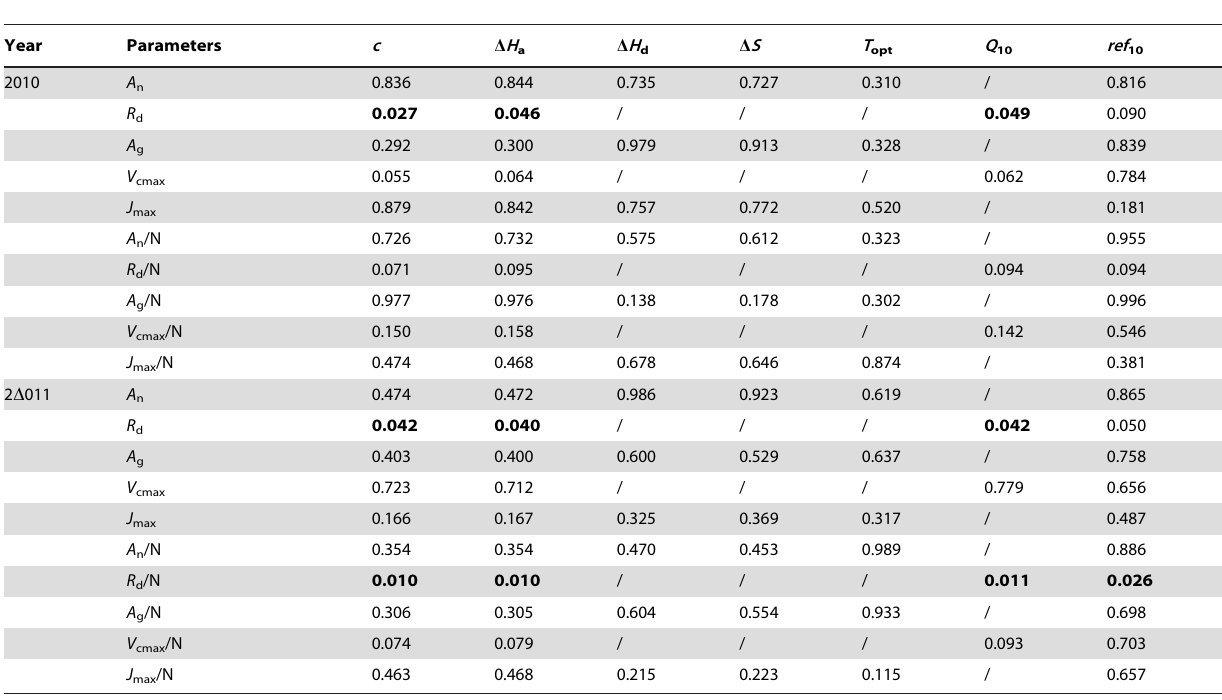
Table 1. Results ( P -values) of one-way ANOVA on the effects of warming on the responses of A n (the net CO 2 assimilation rate), R d (dark respiration), A g (the gross CO 2 assimilation rate), V cmax (the maximum rate of Rubisco carboxylation) and J max (the maximum rate of photosynthetic electron transport) expressed per unit foliar area and nitrogen to instantaneous change (10–40 u C within a 5 h period) in T leaf (foliar temperature) in 2010 and 2011.